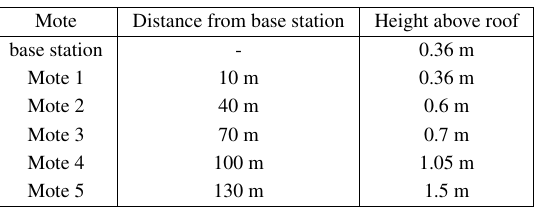
Table 1. Experimental